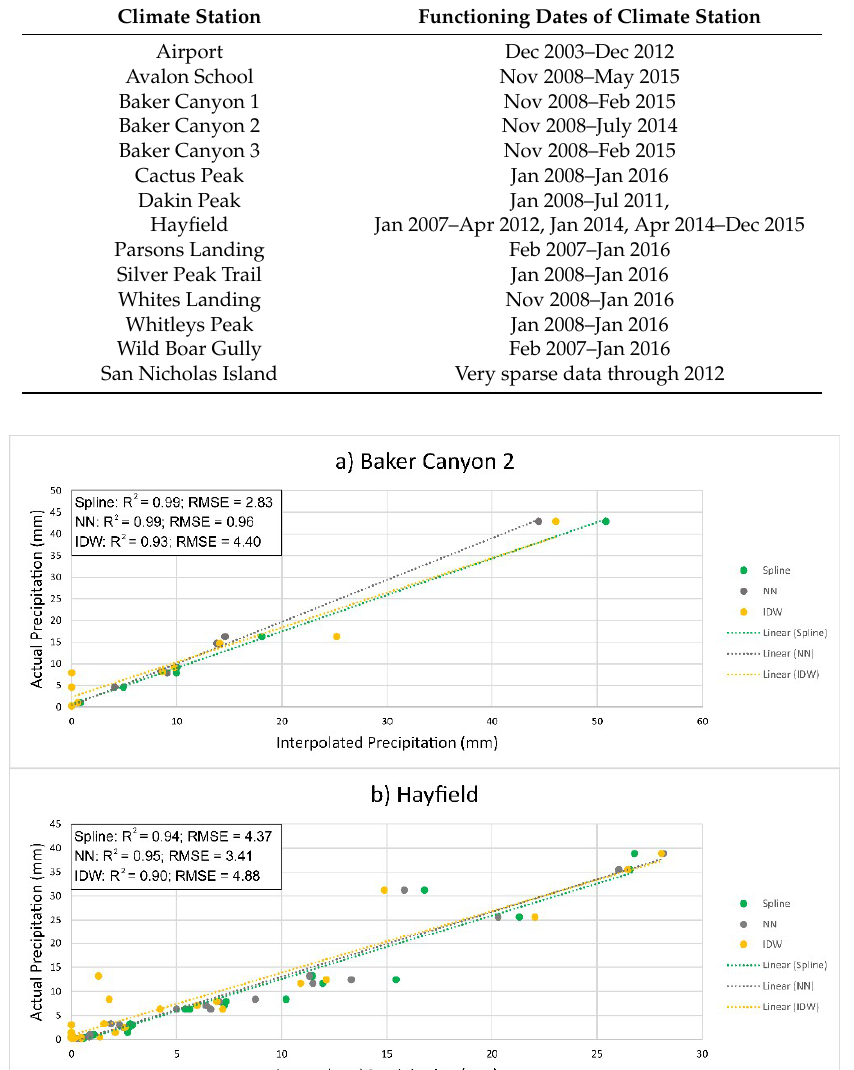
Table 1. Catalina Climate Stations.